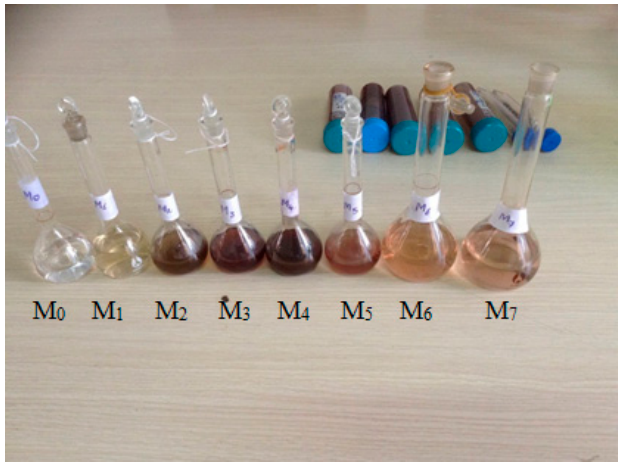
Figure 2. Photograph color change of colloids.